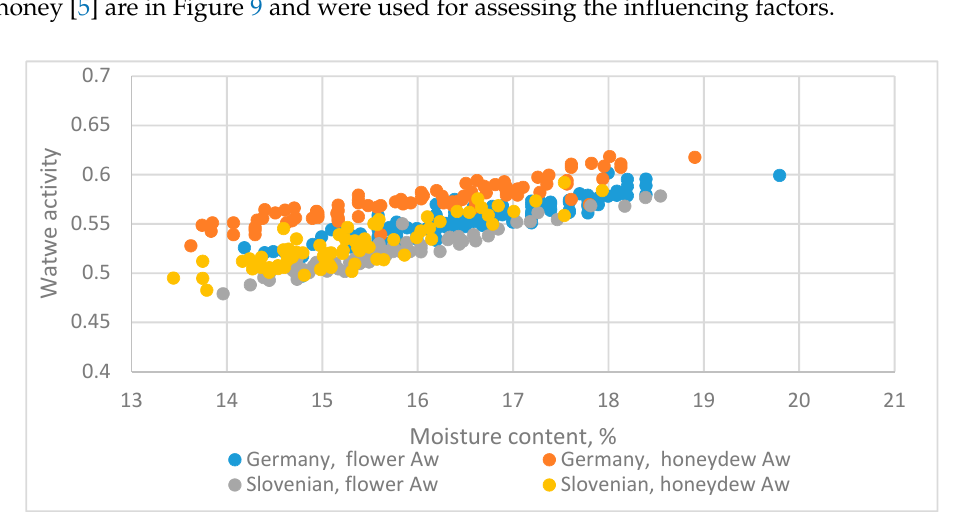
Figure 9. The relationship between water activity and moisture content for datasets for honey from Germany (pooled of the flower and honeydew, liquid state) [8] and Slovenia (liquid state) [5].